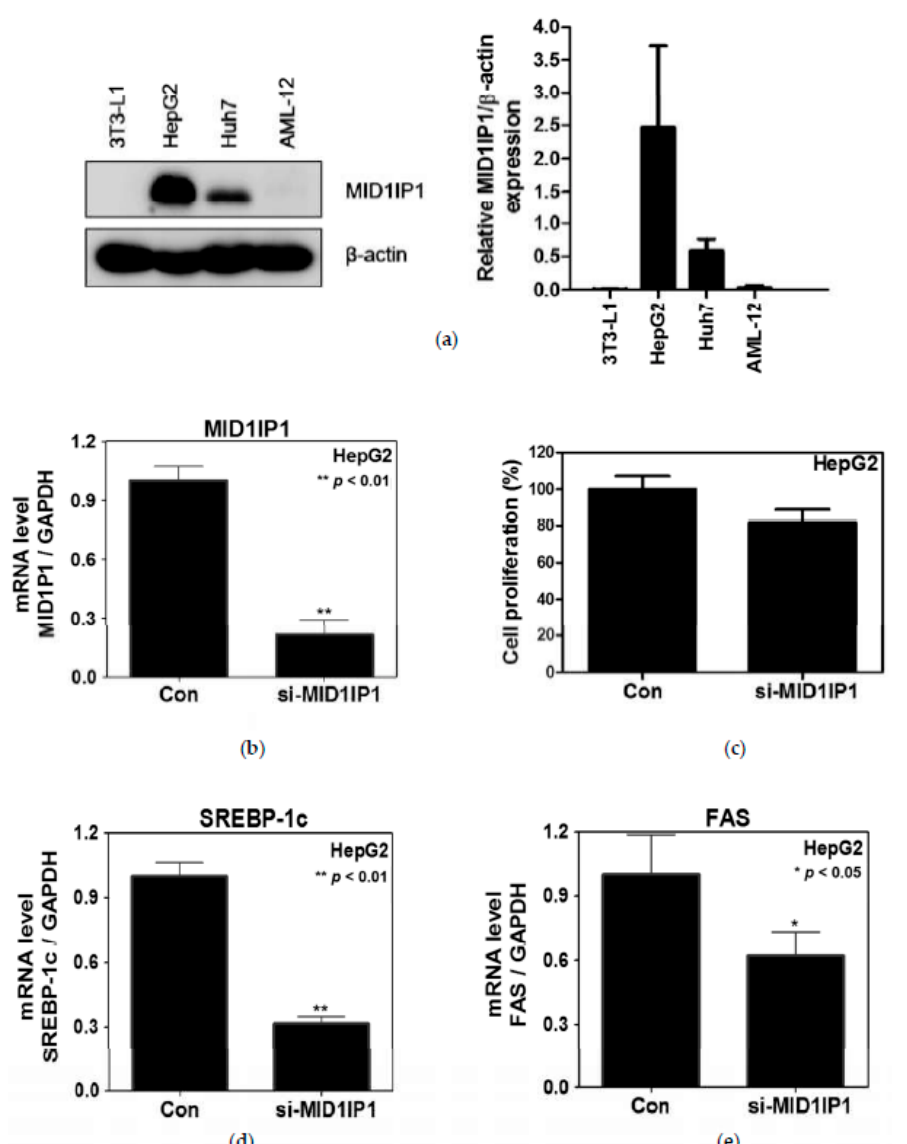
Figure 3. Effect of MID1PI1 depletion on proliferation and lipogenesis-related genes. ( a ) Expression level of MID1IP1 in different cell lines. β -actin was used as loading control. ( b ) Depletion level of MID1IP1 for 48 h in HepG2 cells by qRT-PCR. ( c ) Effect of MID1PI1 depletion on proliferation in HepG2 cells by MTT assay. ( d , e ) Effect of MID1PI1 depletion on the mRNA level of SREBP-1c and FAS in HepG2 cells by RT-qPCR analysis. All experiments were independently performed at least three times.